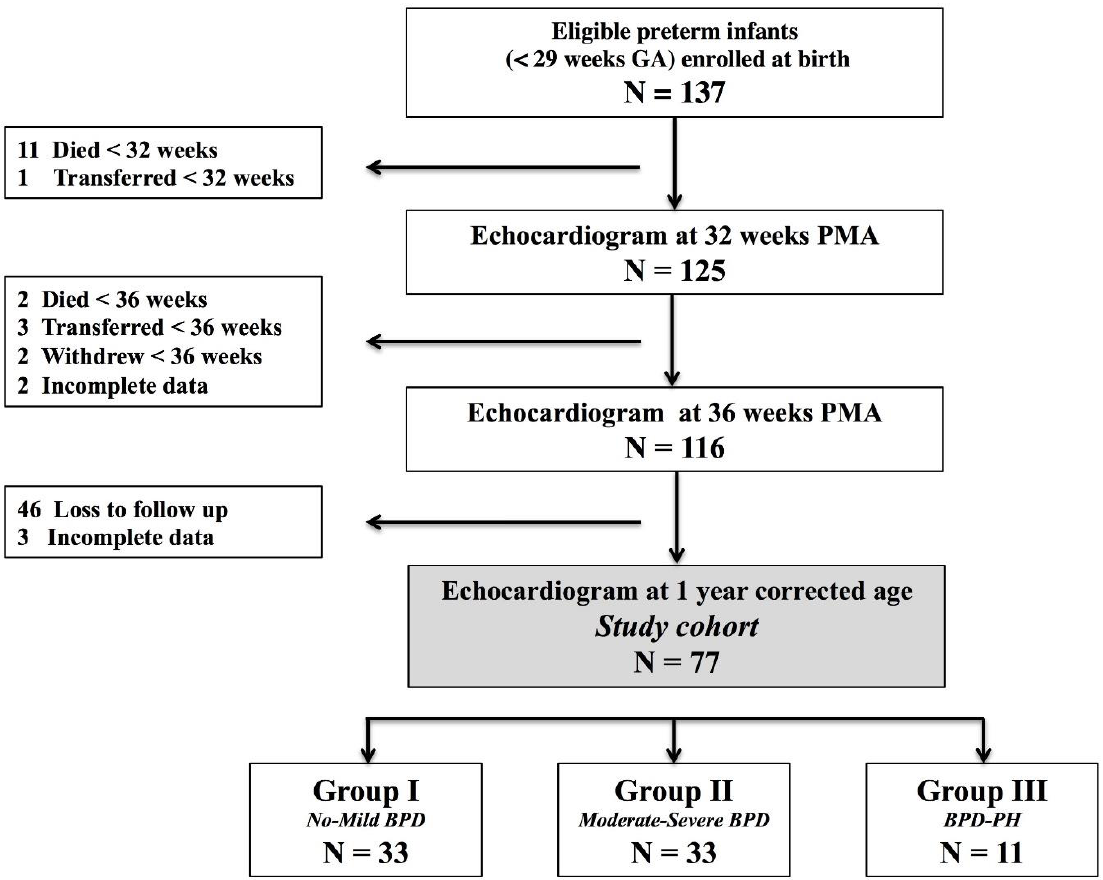
Figure 1. Study flow diagram of preterm infants. GA, gestational age. BPD, Bronchopulmonary dysplasia. PH, Pulmonary hypertension. Of the original 137 infants recruited for the Premature and Respiratory Outcomes Program (PROP) at birth, 77 had echocardiograms at 32 weeks postmenstrual age (PMA), 36 weeks PMA, and 1 year corrected age (CA).